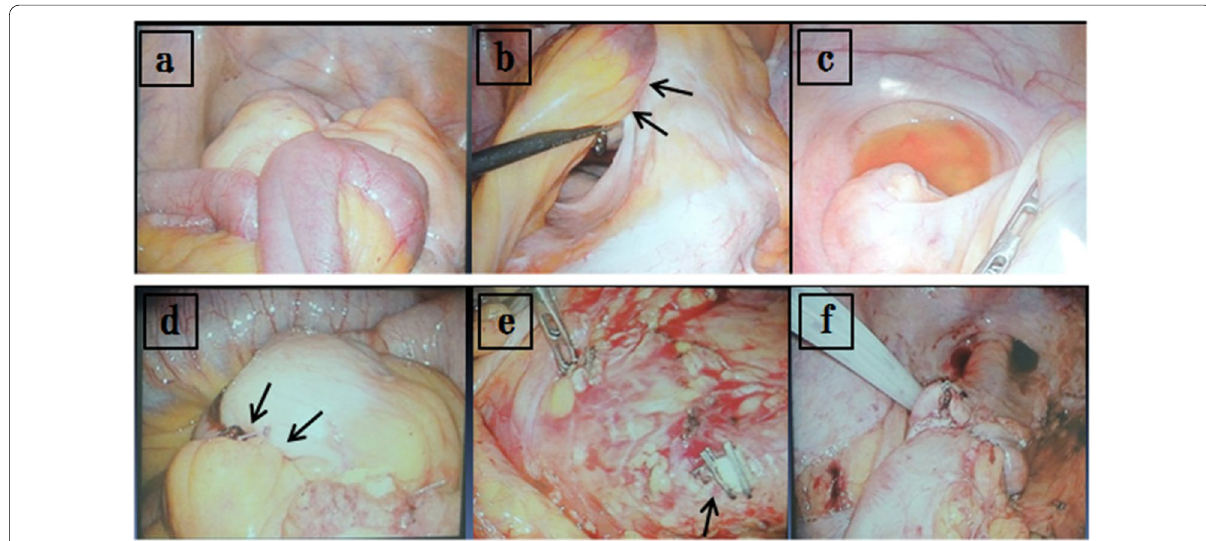
Fig. 3 a, b Tumor invasion was extended to the ileum. The arrow shows ileal invasion caused by sigmoidal tumor. c A small amount of ascites existed in the pouch of Douglas. d The invaded ileum was resected with sigmoid colon cancer. Ileal mesentery resection was performed to a minimum, and the arrow shows ileal mesenteric suture. e, f Laparoscopic high anterior resection with D3 lymph node dissection was performed. The arrow shows inferior mesenteric arterial root